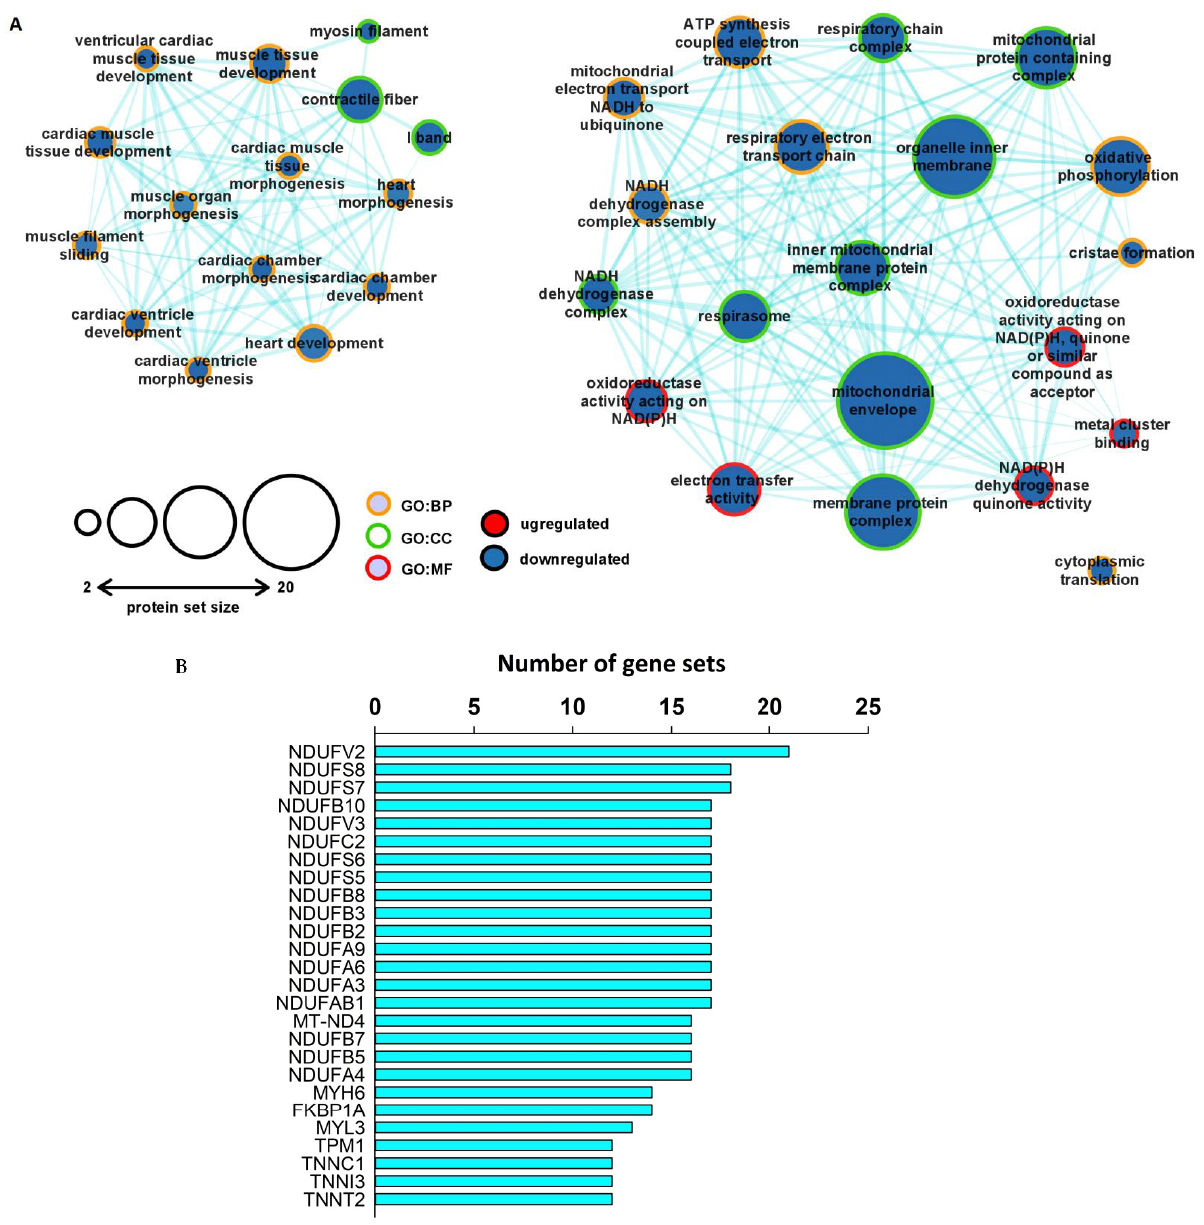
Figure 4. GSEA analysis of the unfiltered proteomic dataset revealed concordant downregulated expression patterns of proteins associated with the arrangement of the contractile and cytoskeletal system, as well as with the mitochondrial respiratory chain. ( A ) Enrichment map of the major GO sets influenced by hypercholesterolemia at the whole proteome level. Pathway enrichment analysis was performed with protein-specific GSEA. Circles represent enriched gene sets (nodes). The node size corresponds to the size of the number of proteins falling into a respective gene set category. The two node colors represent the trend of the quantitative change in the hypercholesterolemic left ven- tricle, while the color of the nodes’ border indicates the respective GO category. Edges represent similarity among the gene sets, as the thickness of each edge corresponds to the overlap between the nodes. The enriched gene sets were visualized with Cytoscape v3.8.2. ( B ) Output of the leading- edge analysis of the enriched GO terms at FDR < 0.1 performed with GSEA. The numbers on the horizontal axis indicate the number of appearances of the respective protein in the significantly en- riched subsets. The graph was created with SigmaPlot v.12.0.